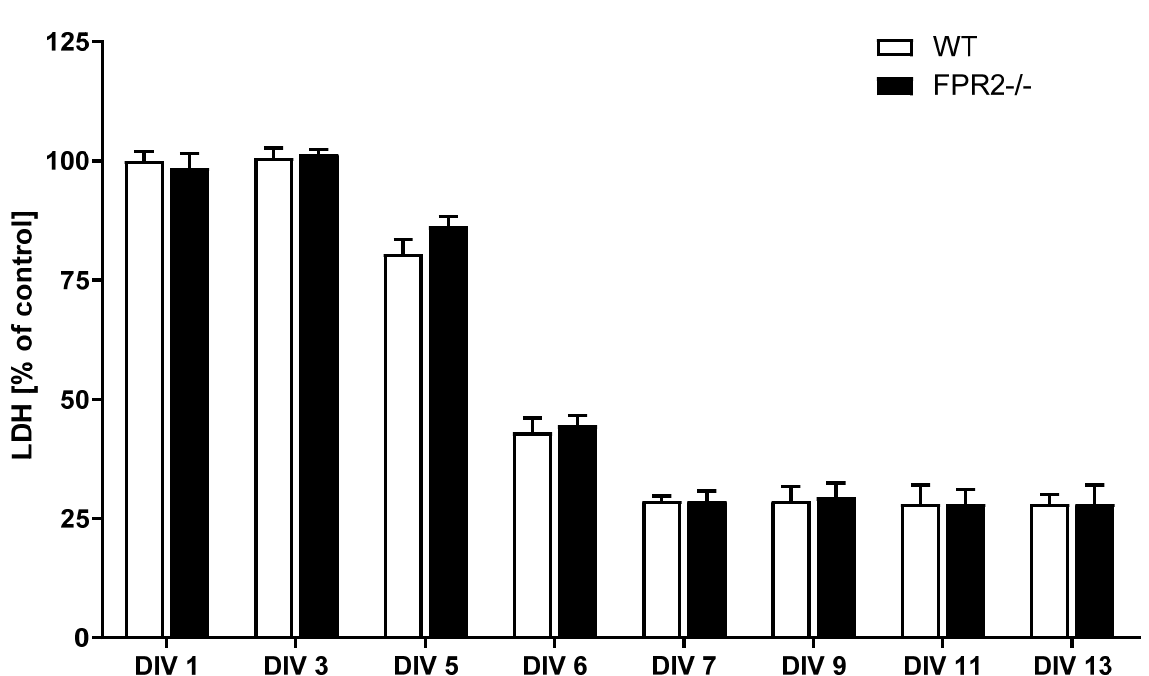
Figure 1. Dynamics of organotypic hippocampal cultures (OHCs) derived from 6–7-day-old offspring of wild-type (WT) and FPR2 − / − (KO) mice. Dynamics of OHCs were assessed using the lactate dehydrogenase (LDH) assay. The data are presented as the mean percentages ± SEM of the control (vehicle-treated WT OHCs). LDH—lactate dehydrogenase; DIV—day in vitro.